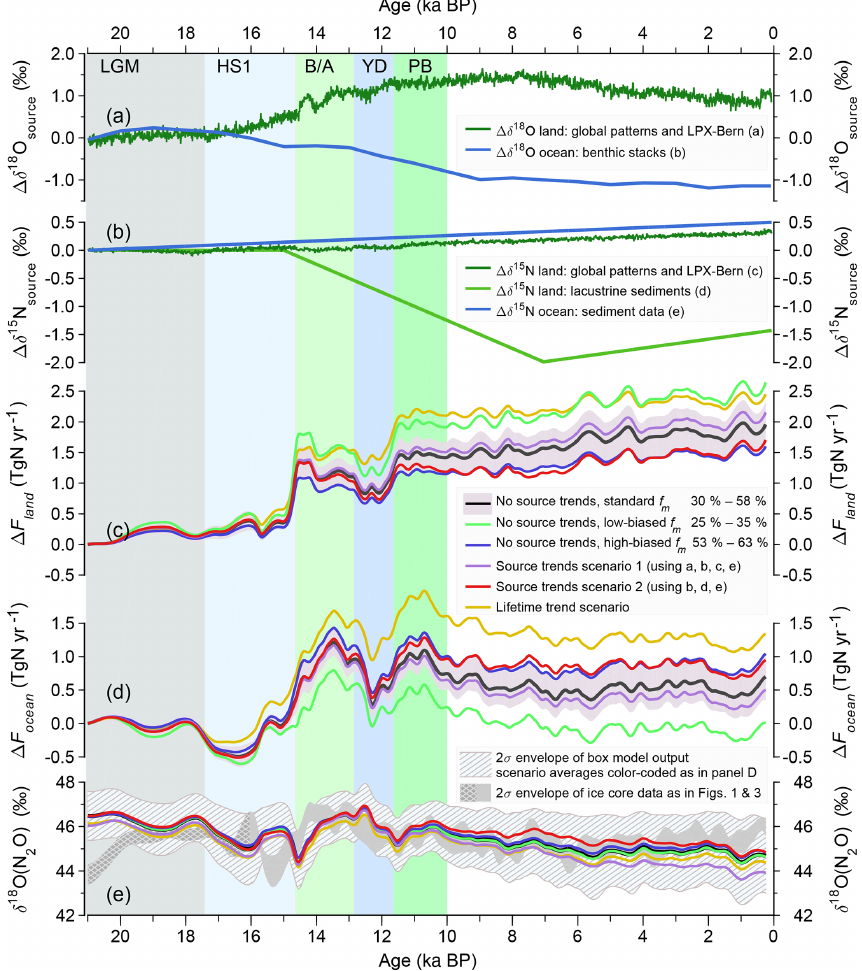
Figure 6. Results from sensitivity analyses to test the robustness of N 2 O emissions inferred by deconvolving the ice core N 2 O and δ 15 N(N 2 O) records. Reconstructed, potential changes in oxygen (a) and nitrogen (b) isotopic source signatures of precursor material relative to 21kaBP. Inferred changes in terrestrial (c) and marine (d) N 2 O emissions anomalies relative to 21kaBP, (e) atmospheric δ 18 O(N 2 O) from ice cores (dark grey band) and inferred from the terrestrial and marine emissions in panels (c) and (d) . Emission anomalies of the standard deconvo- lution in (c) – (e) are shown in black including their ± 1standard deviation uncertainty (grey shading). Sensitivity setups refer to runs with a lowered (green) and elevated (blue) marine source fraction range at the start of the runs, temporal terrestrial source signature changes derived from model data (purple line) and from lacustrine sediments (red line), and using a time-dependent atmospheric lifetime (yellow) as described in detail in Sect. 2.2.3. In both source signature scenarios (purple and red line), marine source signatures are varied according to evidence from marine sediment